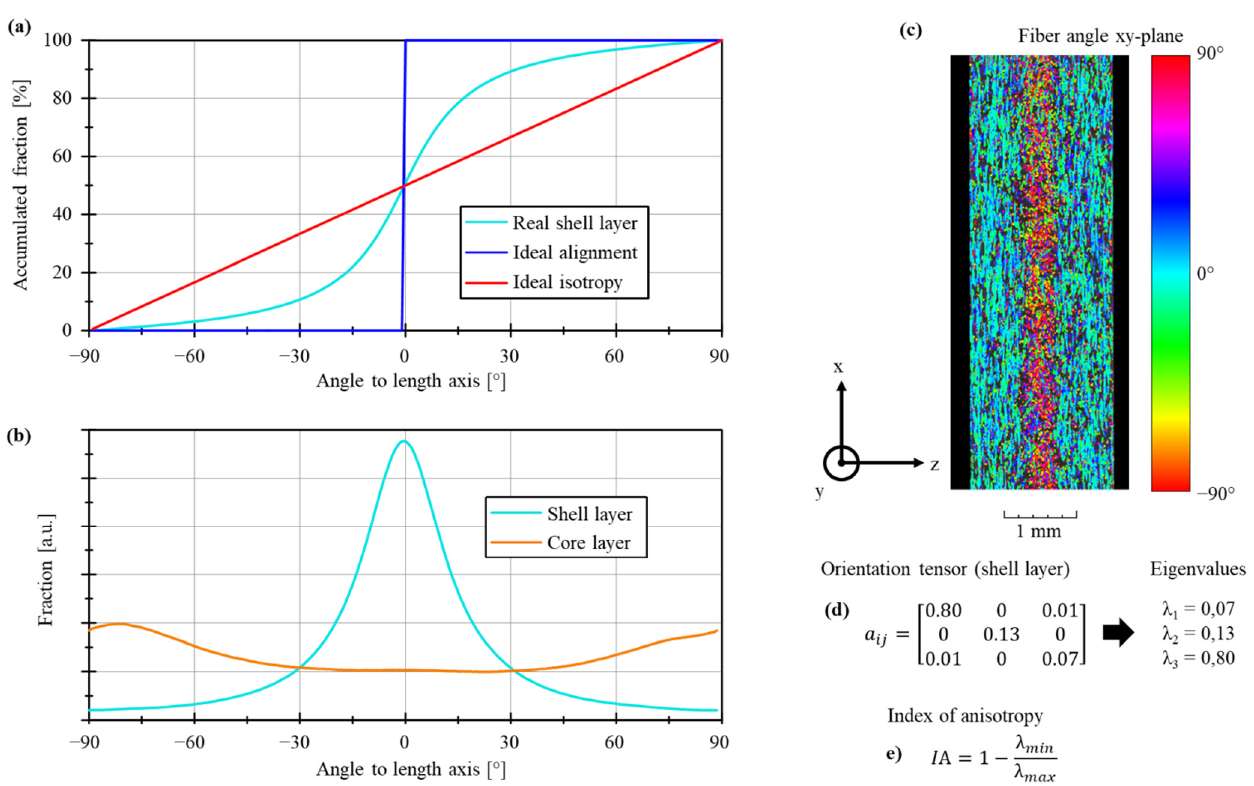
Figure 1. Different ways to display the fiber orientation of short fiber reinforced composites: ( a ) accumulated fiber orientation distribution, ( b ) partial fiber orientation distribution, ( c ) colorized micro-section by µCT, ( d ) fiber orientation tensor, and ( e ) index of anisotropy determined by the eigenvalues of the orientation tensor [3].